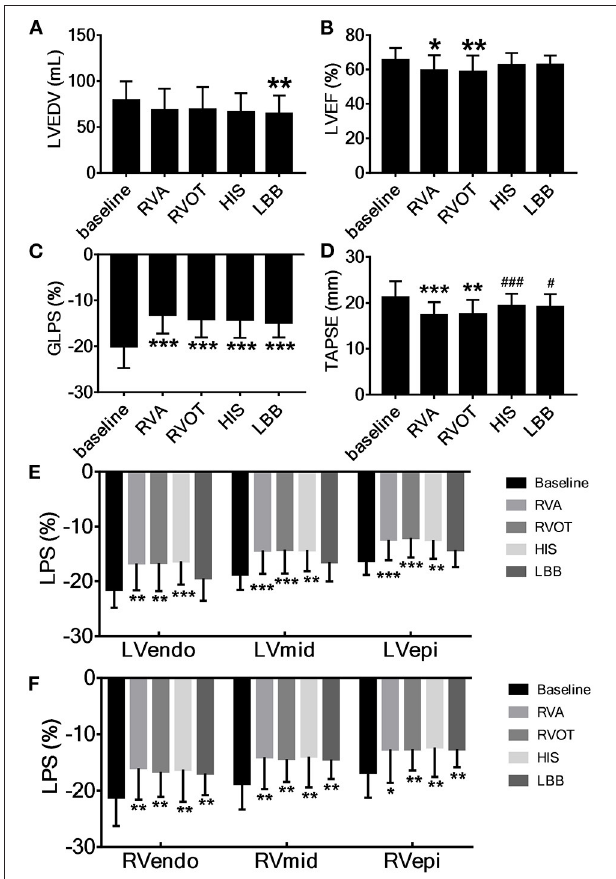
FIGURE 3 | Acute change in cardiac contraction associated with pacing at the different sites. (A) LVEDV, left ventricular end-diastolic volume, (B) LVEF, left ventricular ejection fraction, (C) GLPS, global longitudinal peak strain, (D) TAPSE, tricuspid annular plane systolic excursion. (E) The longitudinal strain of left ventricular endocardium (LVendo), mid-myocardium (LVmid) and epicardium (LVepi). (F) The longitudinal strain of right ventricular endocardium (RVendo), mid-myocardium (RVmid) and epicardium (RVepi). * P < 0.05, ** P < 0.01, *** P < 0.001 vs. baseline, # P < 0.05, ### P < 0.001 vs. right ventricular apex